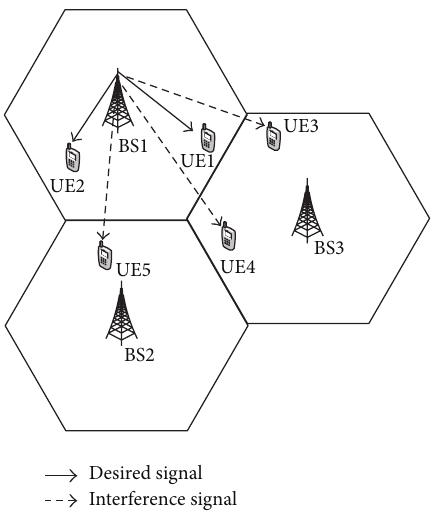
Figure 1: MU-MIMO system with generated